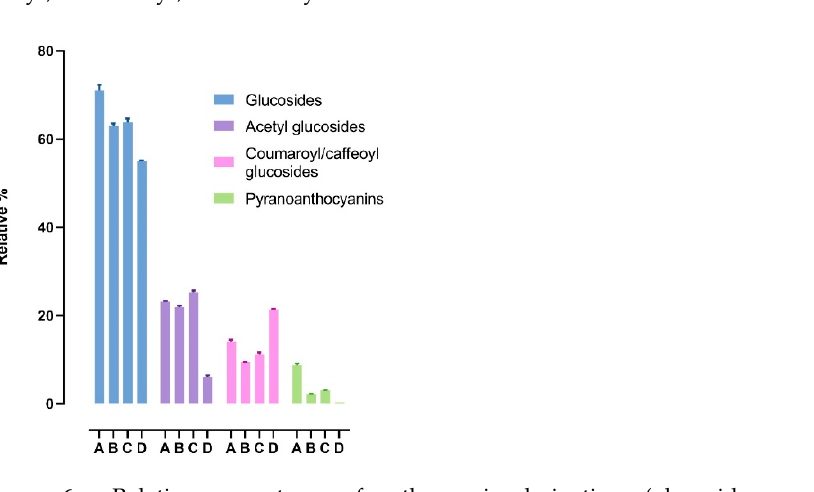
Figure 6. Relative percentages of anthocyanin derivatives (glucosides, acetyl glucosides, coumaroyl/caffeoyl glucosides, pyranoanthocyanins) found in the four samples (A, B, C, D). Data are reported as mean ± SD.